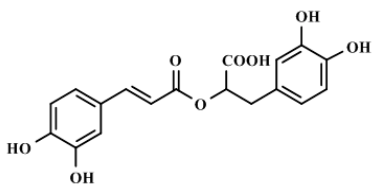
Figure 1. Chemical structure of RA or (2 R )-3-(3,4-dihydroxyphenyl)-2-{[(2 E )-3-(3,4-dihydroxyphenyl)-2-propenoyl]oxy}propanoic acid (IUPAC).